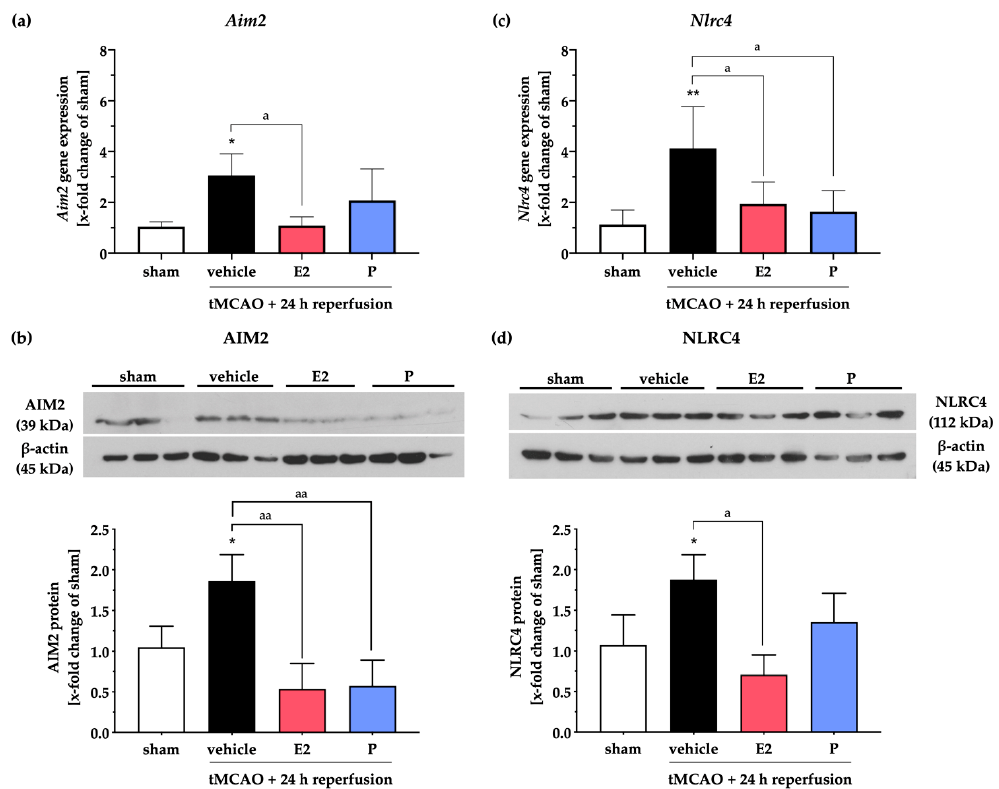
Figure 3. E2 or P therapy selectively modulates AIM2 and NLRC4 inflammasomes 24 h after cerebral ischemia. The AIM2 gene, as well as the protein levels, were elevated after tMCAO. The mRNA transcripts of Aim2 were significantly reduced after E2 therapy ( a ), whereas both steroid hormones were efficacious in AIM2 protein reduction in the peri-infarct area ( b ). Stroke exhibited a marked increase in NLRC4 gene and protein levels. Both steroid hormones were capable of diminishing Nlrc4 gene expression ( c ), but only E2 could reduce NLRC4 protein levels ( d ). p -values: */a ≤ 0.05; **/aa ≤ 0.01; asterisks indicate sham vs. the other groups; letters indicate vehicle vs. E2 or P. Data represent the means ± SEM. n = 5 (gene expression) or n = 4 (WB data). tMCAO–transient Middle Cerebral Artery